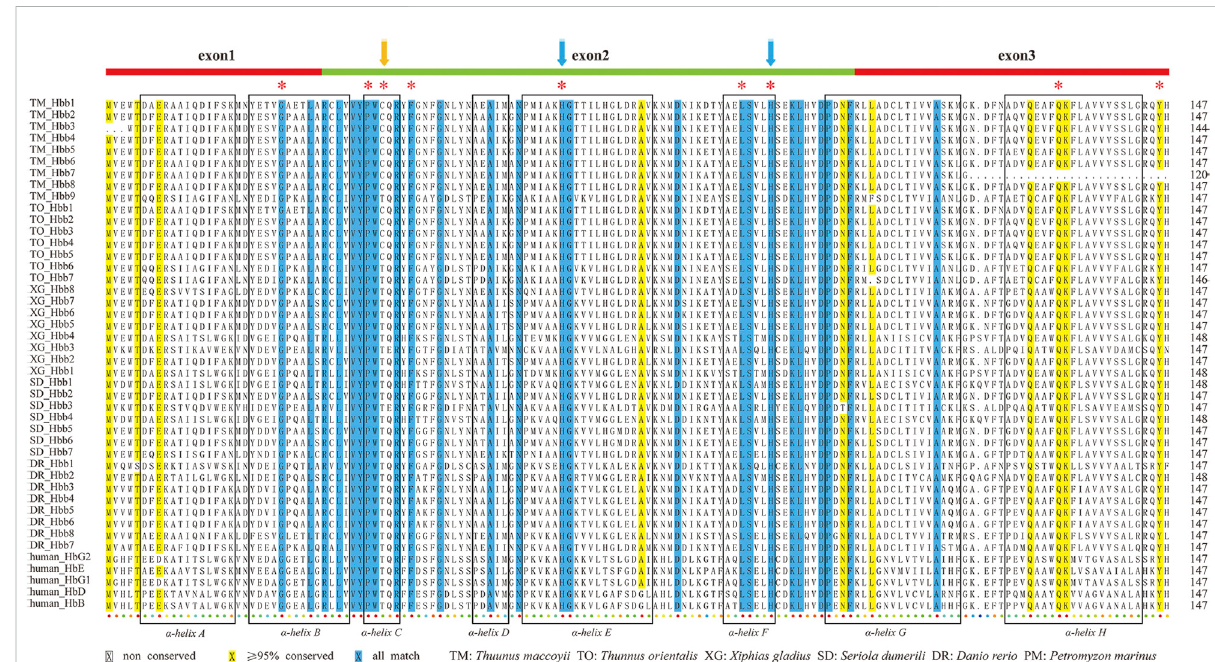
FIGURE 5 ClustalX alignments of β -hemoglobins from six representative species. Eight boxes with α -helical segments were named as A ~ H. Conserved distalandproximalhistidineresiduesweremarkedbyasterisks.Twobluearrowsindicatethedistalandproximalhistidinesforputativeinvolvementin theheme binding.The orangearrowsmarkedthelocithatare uniquetotunas (cysteine),whicharedifferentfromthoseinotherspecies(threonine). Alignments of α -hemoglobins are also provided in Supplementary Figure S4 for